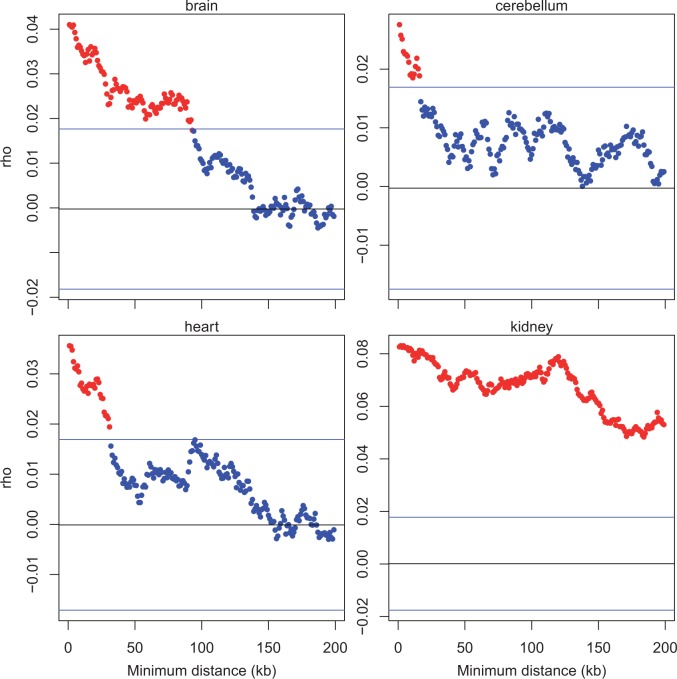
The extent of local correlation in sex-biased expression change for four tissues. Method is the same as that for figure 3, excepting that here we employ standardized residuals of the orthologous regression on Z between sexes (rather than Z). We consider all focal genes and the correlation between residuals of Z scores for these genes and the nearest downstream gene on the same chromosome a minimum of x base pairs away. Correlations significant at the 0.05 level are shown in red, otherwise in blue. The blue horizontal lines indicate 1.96 SD limits determined by randomization, with the black line indicating mean of null expectation (which should be around zero).